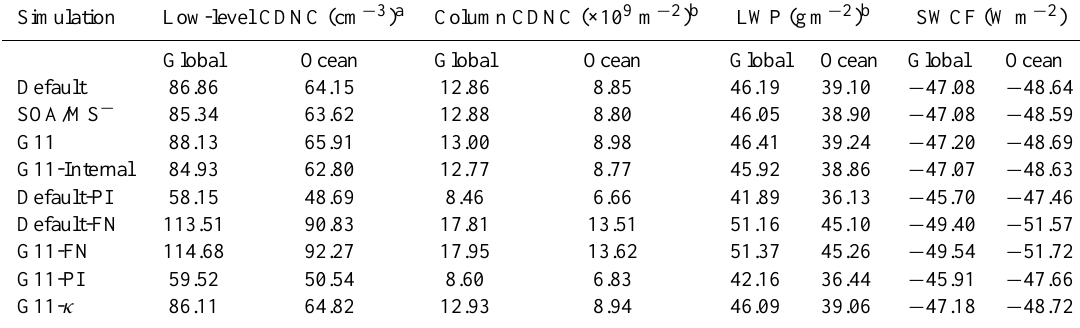
Table 2. CAM5 modeled mean liquid cloud properties.